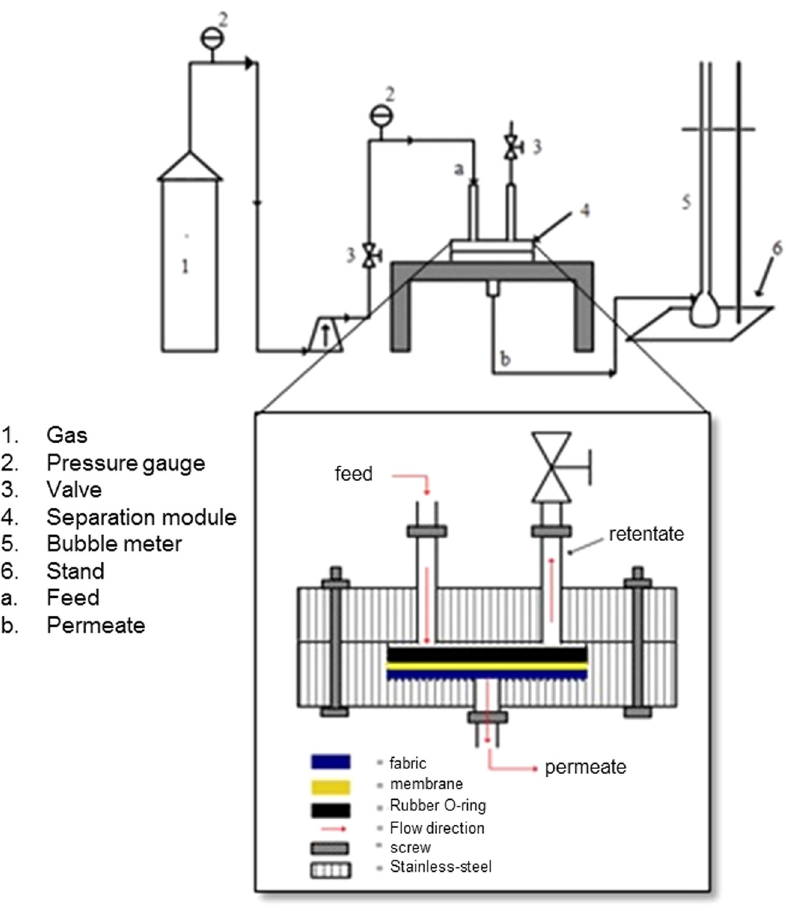
Figure 1: Single gas permeation rig ( adapted from Gunawan et al. [ 36 ])